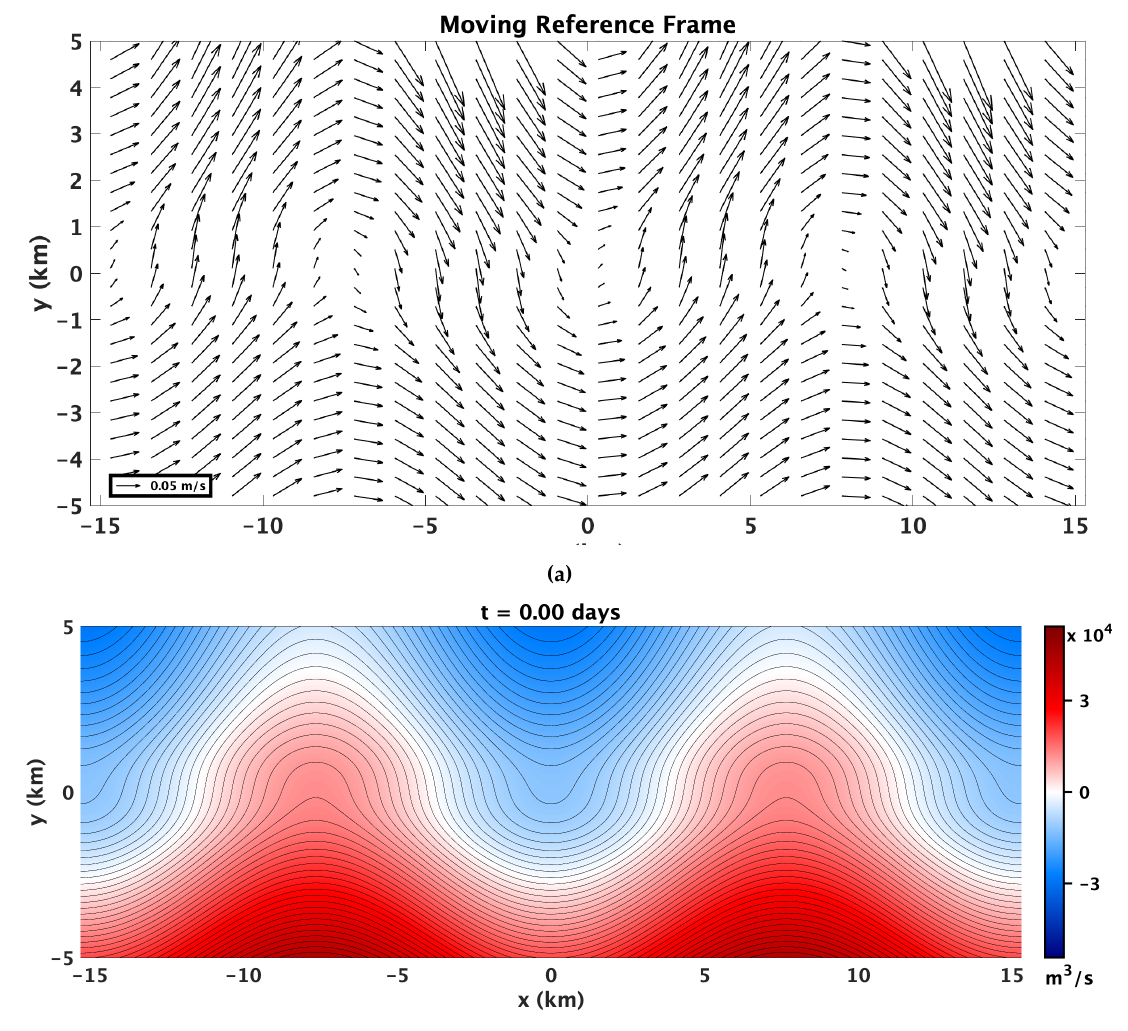
Figure 2. ( a ) Model velocity field and ( b ) volume-transport streamfunction Ψ at t = 0 for the base case parameters in Table